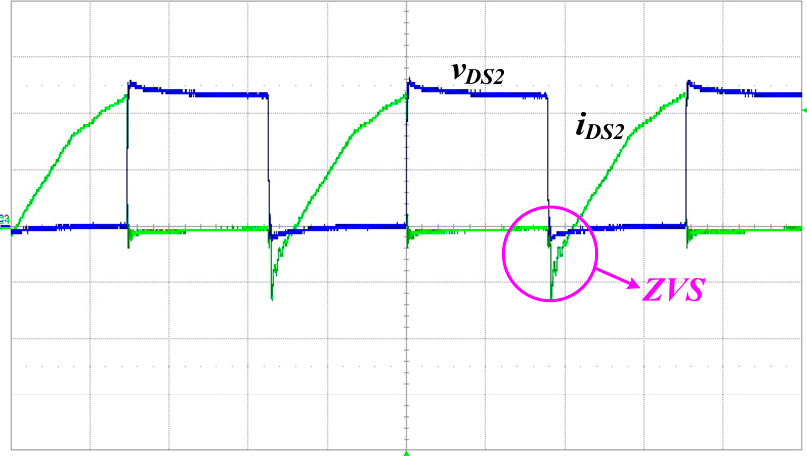
Figure 10. Measured switch voltage v DS 2 (200 V/div) and current i DS 2 (2 A/div); time scale: 5 μ s/div.